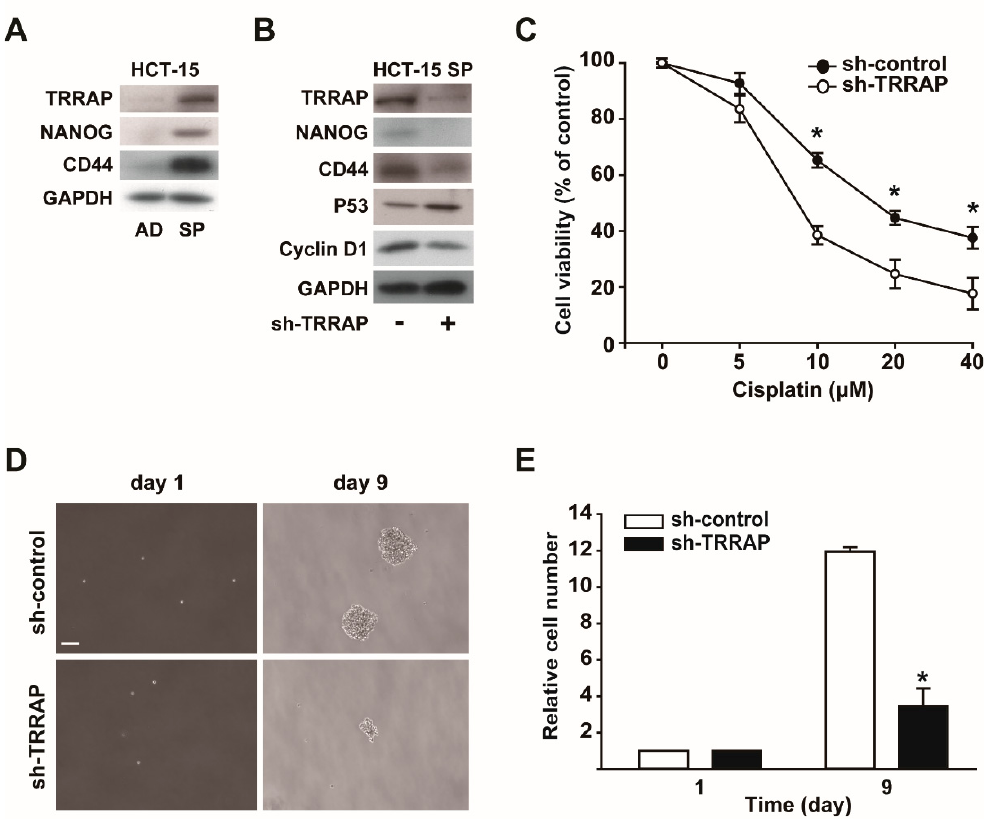
Figure 4. E ff ects of TRRAP silencing on the proliferation and drug resistance of HCT-15 spheroids. ( A ) The expressions of TRRAP and NANOG increased in spheroid cultures of HCT-15 cells. The expression of TRRAP, NANOG, CD44, and GAPDH were measured in adherent (AD) and spheroid (SP) cultures of HCT-15 colon cells. ( B ) E ff ects of the shRNA-mediated silencing of TRRAP on the expression levels of CSC-associated genes. HCT-15 spheroids (HCT-15 SP) were infected with or without lentiviruses bearing TRRAP shRNA, and the expression levels of TRRAP, NANOG, CD44, P53, cyclin D1, and GAPDH were measured via Western blot analysis. ( C ) E ff ects of TRRAP silenc- ing on drug resistance in HCT-15 spheroids. HCT-15 spheroids were infected with lentiviruses bear- ing control shRNA (sh-control) or TRRAP shRNA (sh-TRRAP), treated with increasing concentra- tions of cisplatin for 24 h, and their cell viability was measured. * indicates p < 0.05 by Student’s t- test. ( D ) E ff ects of TRRAP silencing on the spheroid-forming ability of HCT-15 cells. HCT-15 cells were infected with sh-control or sh-TRRAP lentiviruses, and bright fi eld images of the spheroids were taken on days 1 and 9. Scale bar: 100 µm. ( E ) E ff ects of TRRAP silencing on the proliferation of HCT-15 spheroids. The cell numbers were counted on days 1 and 9 after TRRAP silencing. Results are presented as the mean ± SD. * indicates p < 0.05 by Student’s t-test. To explore the role of TRRAP in regulating endogenous NANOG levels, TRRAP ex- pression was silenced using TRRAP shRNA in HCT-15 spheroid cells. TRRAP knockdown reduced the protein levels of NANOG, CD44, and cyclin D1, in contrast to the increase in the protein level of P53, a well-known tumor suppressor gene in colorectal cancer [22], in response to TRRAP silencing (Figure 4B). It has been reported that NANOG [23] or CD44 [24] play key roles in developing resistance to cisplatin. Therefore, we examined the e ff ects of TRRAP silencing on drug resistance in HCT-15 spheroids. Cisplatin treatment inhibited the viability of HCT-15 cells in a dose-dependent manner, and TRRAP silencing potenti- ated cisplatin-induced cell death (Figure 4C). Furthermore, TRRAP knockdown signi fi - cantly decreased the spheroid-forming ability and proliferation of HCT-15 cells in three- dimensional suspension cultures (Figure 4D,E).